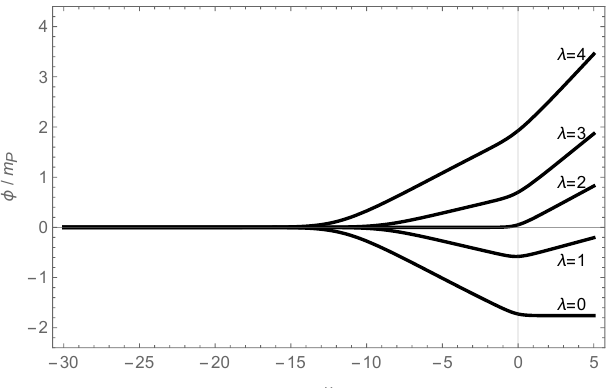
Figure 1. Evolution of the scalar field φ , which plays the role of dark energy, for different values of the parameter λ . At a certain point, this field becomes dominant and induces an accelerated phase of expansion of the universe. Present time corresponds to u 0 = − ln ( 1 + z 0 ) = 0.